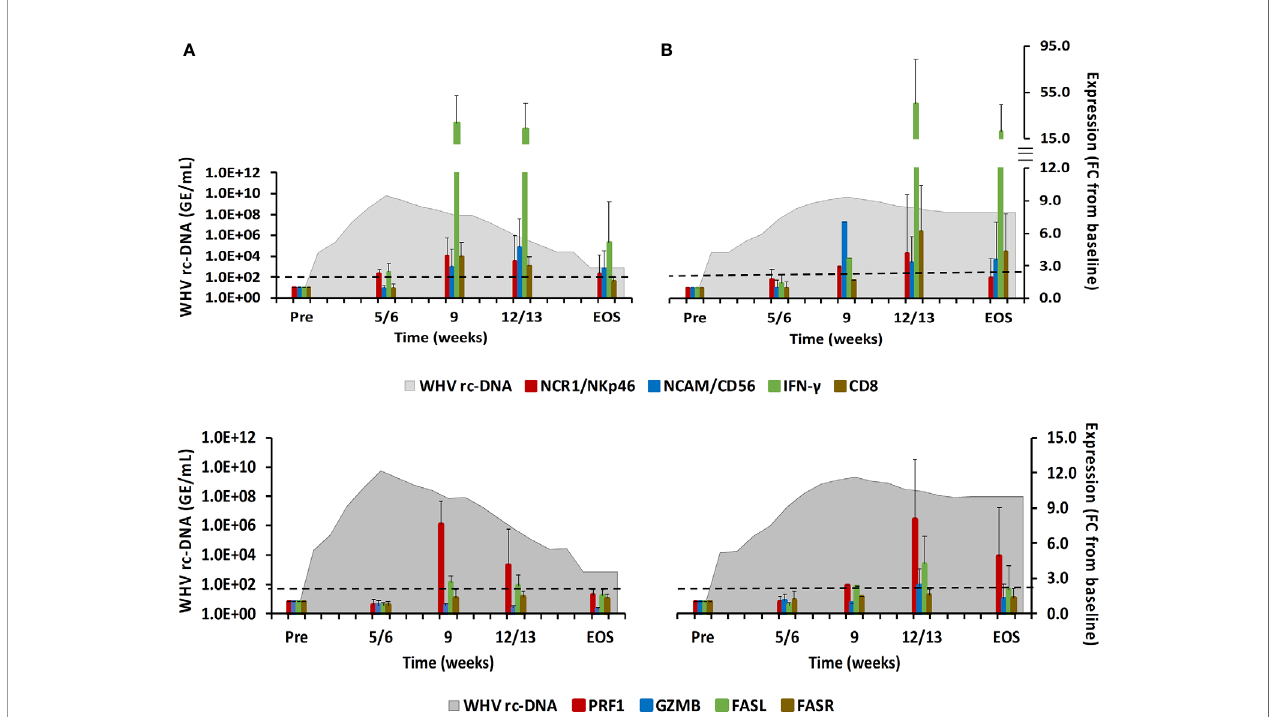
FIGURE 2 | Intrahepatic immune cell marker and cytolytic effector molecule expression. Expression changes of NK-cell and CTL markers (top-panels) and of the cytolytic effector molecules PRF, GZMB, FASL, and FASR (bottom panels) in liver with WHV rc-DNA kinetics of woodchucks during AHB with (A) normal resolution (n=5) and (B) delayed resolution (n=5). The fold-changes in immune cell marker and cytolytic effector molecule transcript level is plotted on the right y-axis, while serum WHV rc-DNA loads are plotted on the left y-axis. The horizontal, dotted line indicates the cutoff for positive expression (i.e., ≥ 2.1-fold increase from the pre-inoculation baseline). Horizontal bars represent the standard error of the mean. Pre, pre-inoculation for AHB; EOS, end of study; FC,